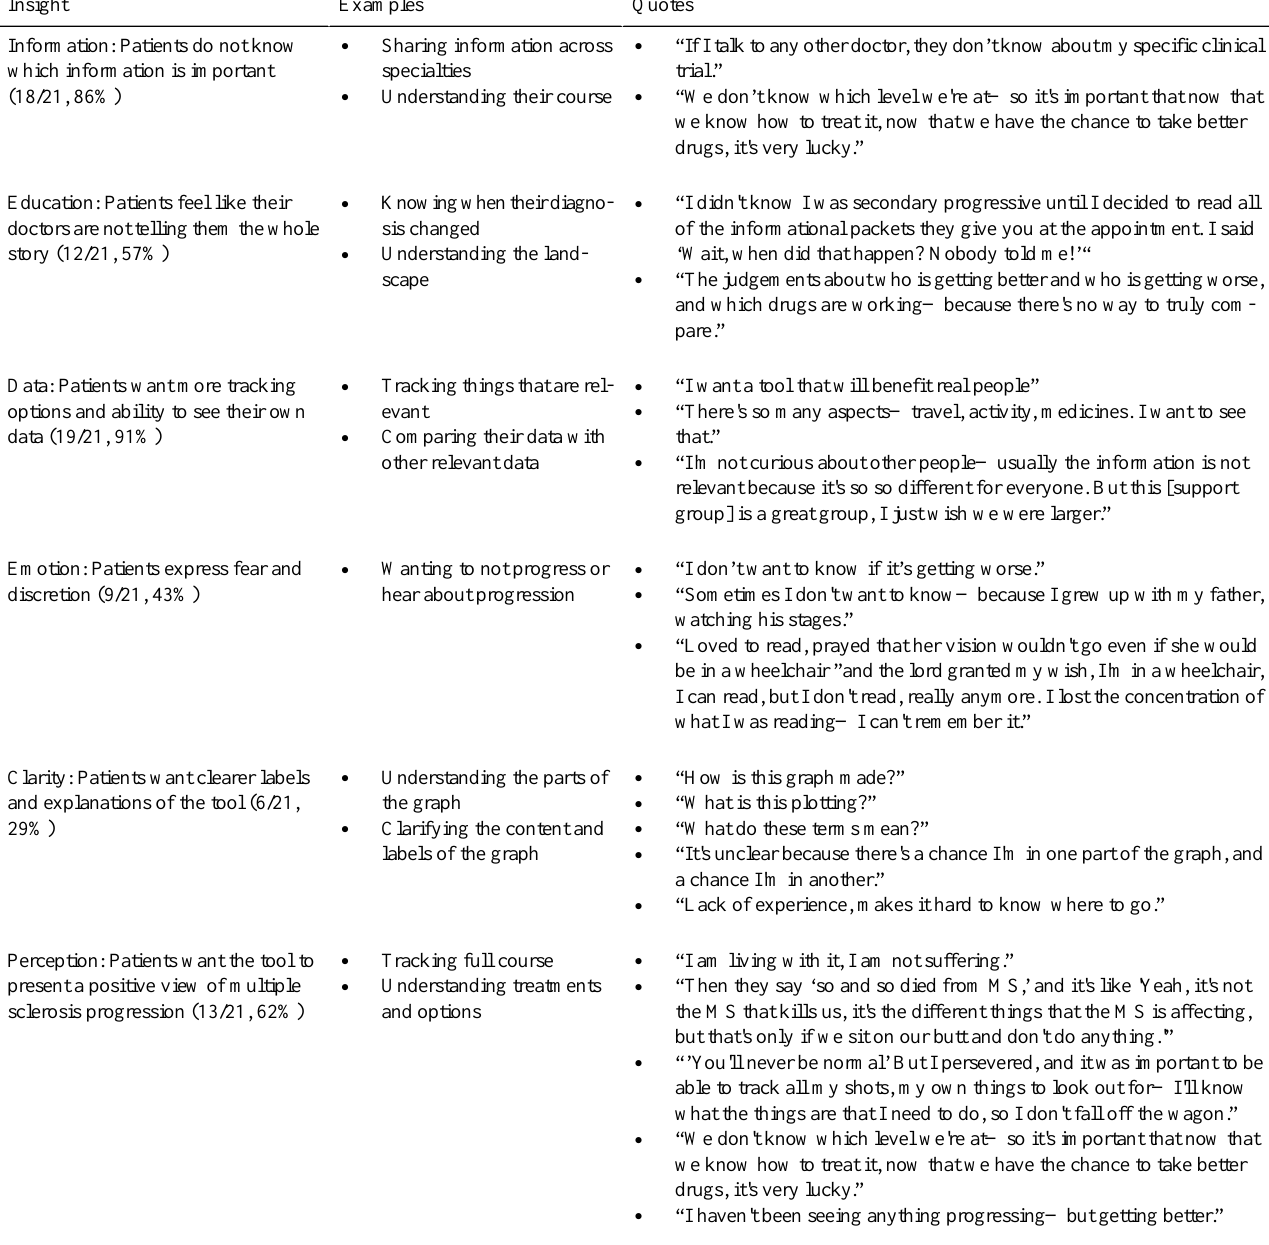
Table 3. Insights derived from 21 patients who viewed